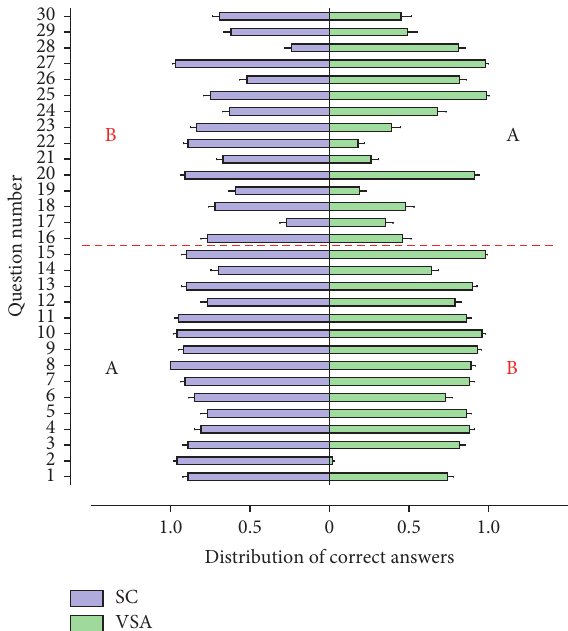
Figure 4: Distribution of correct answers in groups A and B in the winter semester 2017/2018. When single best answer questions (SC) were provided first (group A-SC#1–15), the results were better ( p < 0 . 05) than in students that were given SC questions last (group B-SC#16–30). The same phenomenon was noted for very short answer questions (B-VSA#1–15 versus